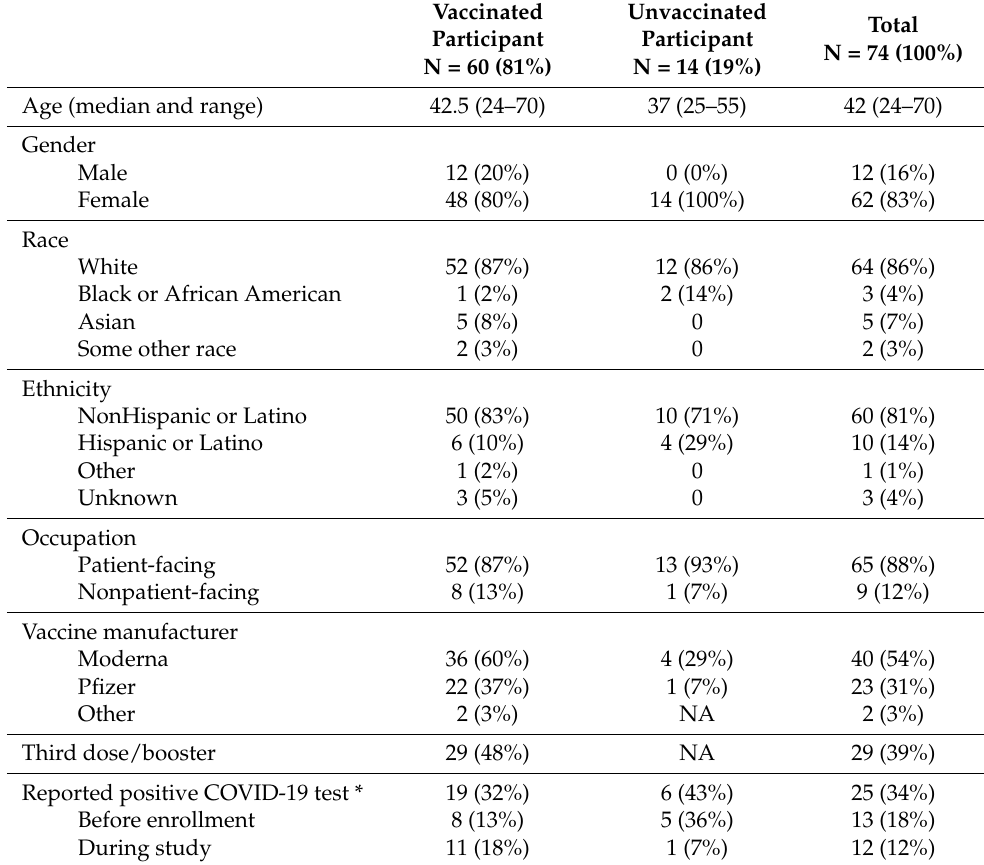
Table 1. Summary of participants in the study. Data are N (%) unless otherwise